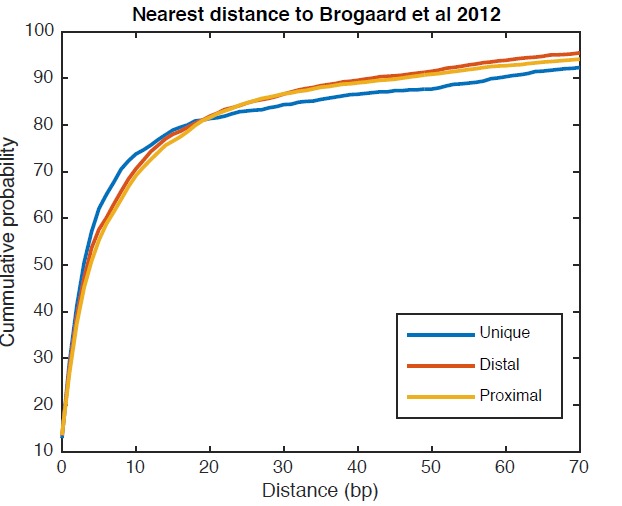
Cumulative distribution of the nearest distance analysis for TBB positions around gene TSSs.The curves show the cumulative distribution of the nearest distance between the TBB nucleosome positions at gene TSSs analyzed for Figure 5C and the nucleosome positions mapped by the chemical approach. Uniquely positioned nucleosomes and alternatively positioned nucleosomes (both distal and proximal nucleosomes) are analyzed separately.